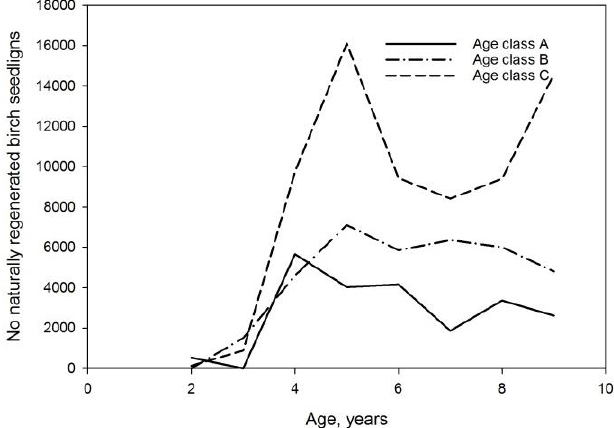
Figure 2. The number of sprouts ( A ) and share of birch sprouts of the total number of sprouts ( B ).